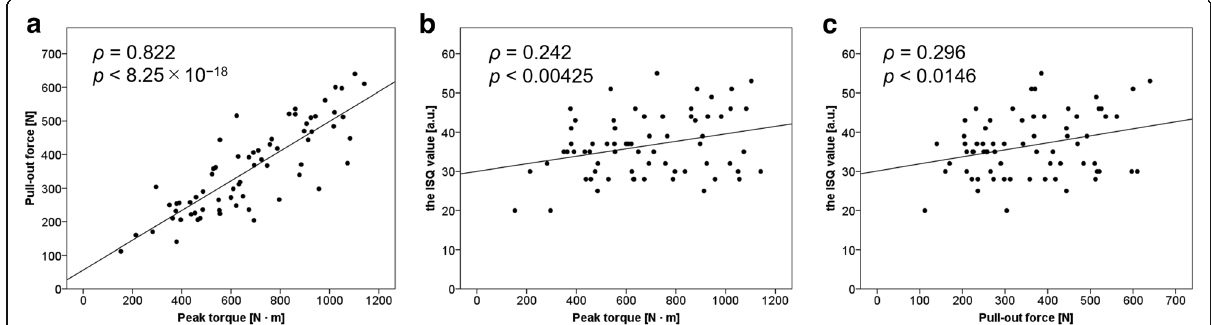
Fig. 4 Scatter plots and best fit lines of linear regression among the three test forces. a Peak torque versus pull-out force. b Peak torque versus implant stability quotient (ISQ) value. c Pull-out force versus implant stability quotient value. N , Newton; N m Newton meter, a.u. arbitrary